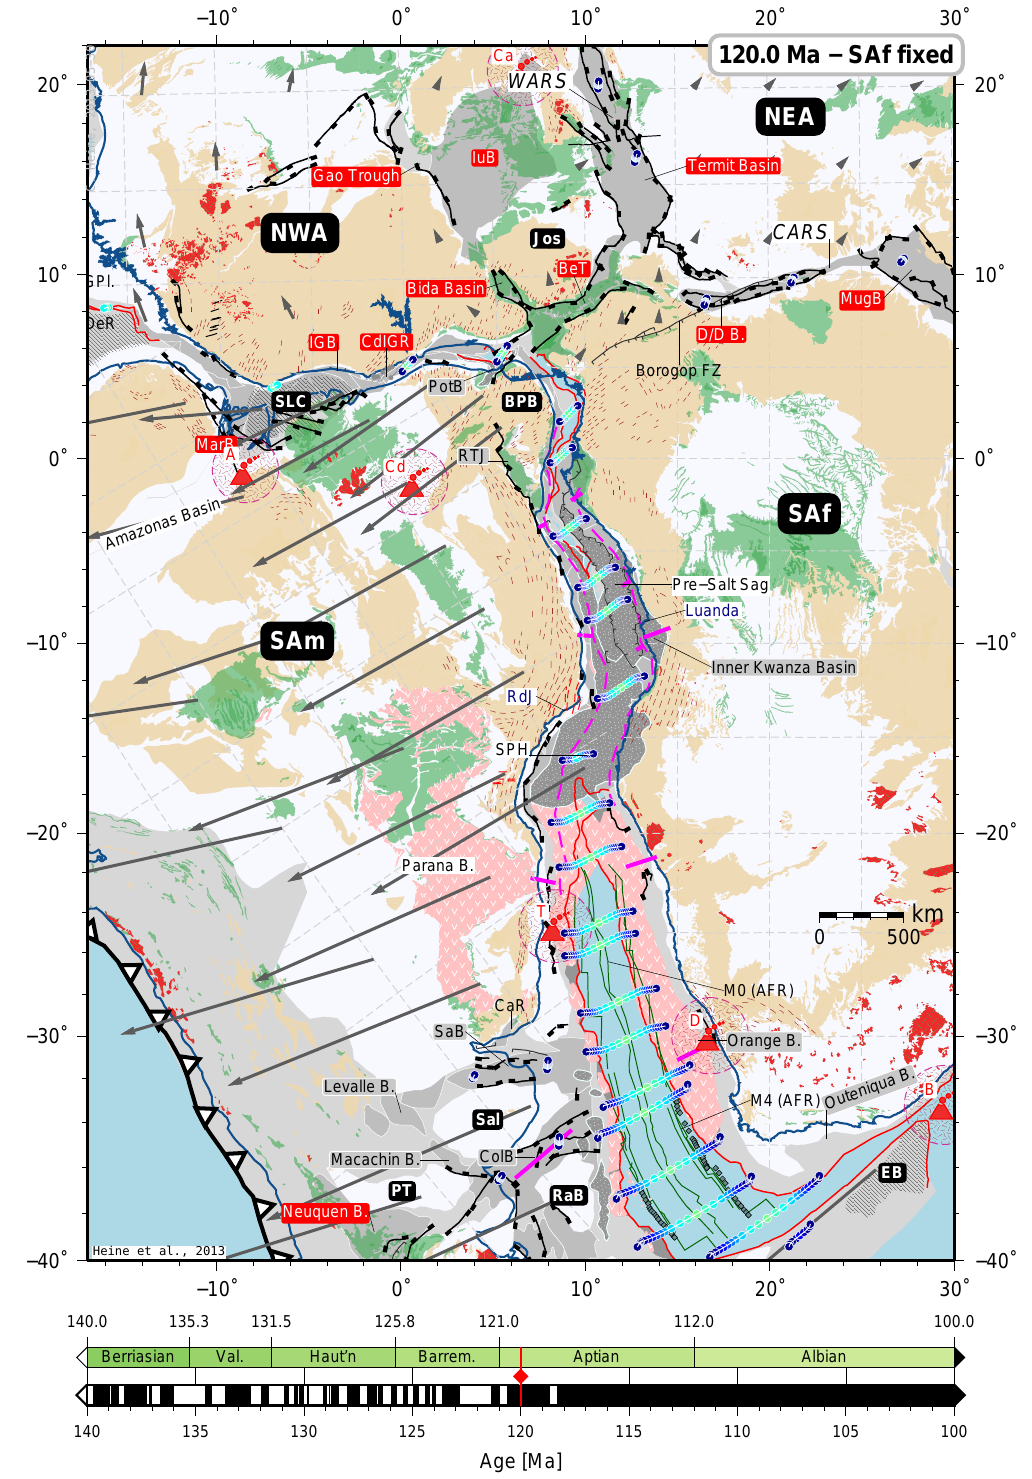
Fig. 18. Plate tectonic reconstruction at 120Ma, with Africa fixed in present-day coordinates. For map legend see Fig. 22, abbreviations as in Fig. 13. Significant increase in extensional velocities causes break-up and subsequent seafloor spreading in the northernmost part of the South Atlantic rift extending down to the conjugate Cabinda/Espirito Santo segment. Due to changed kinematics, rifting and extension in the Santos/Benguela segment focusses on the African side, causing the transfer of the S˜ao Paulo High block onto the South American Plate. Break-up also occurs between Guinea Plateau and Demerara Rise in the westernmost part of the equatorial